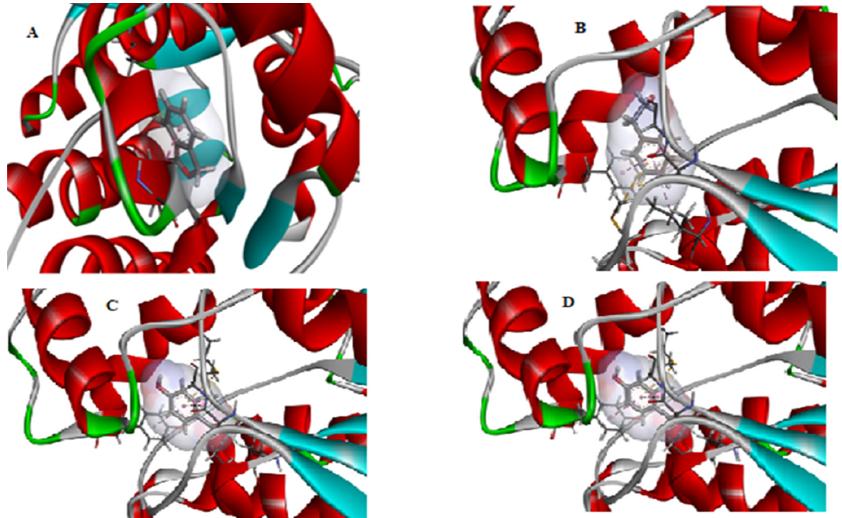
Figure 8. 3D structures of the interactions between the 3HNR receptor and the studied ligands; (A): Phtalide; (B): p-Hydroxybenzaldehyde; (C): Tyrosol; (D): Phenylethyl